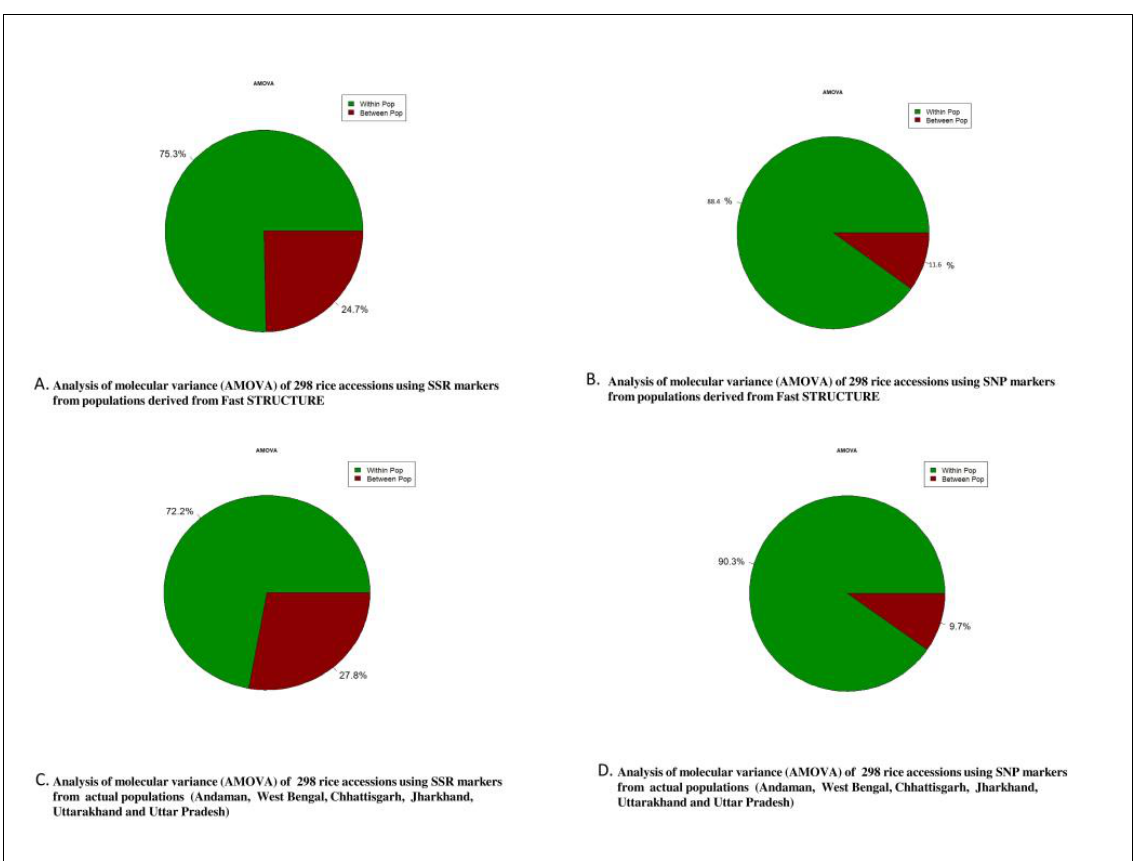
Figure 8. Analysis of molecular variance (AMOVA) of 298 rice landraces using SSR and SNP mark- ers .